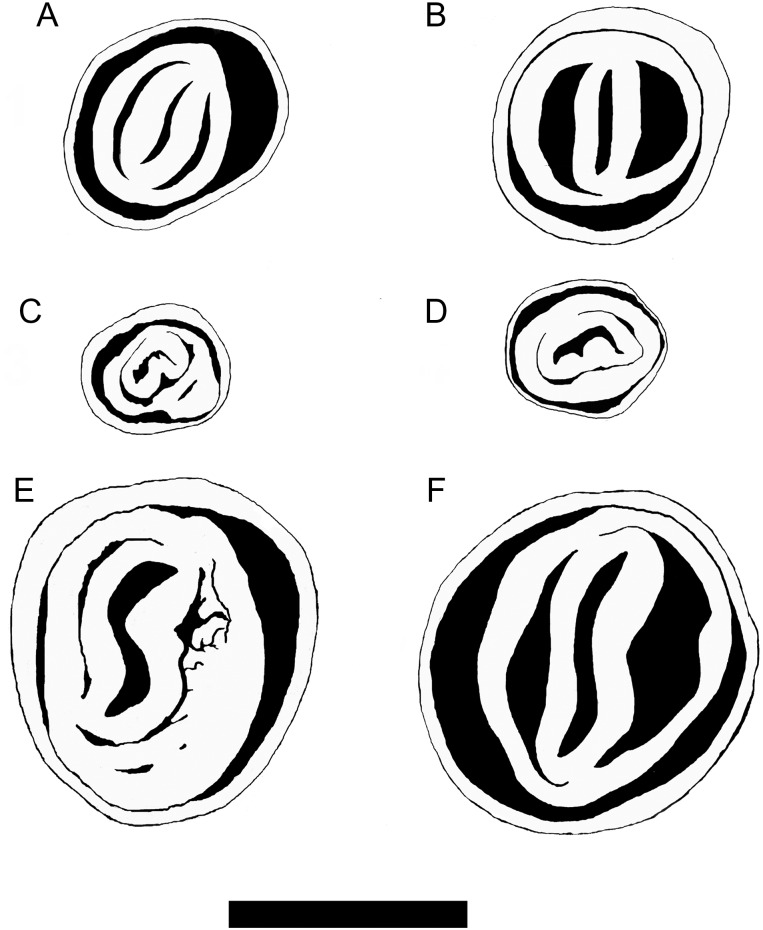
Ground patterns of penis cross section in the Trochulus hispidus complex, T. striolatus subspp. and T. oreinos subspp. A. T. hispidus complex with small folds. B. T. hispidus complex with broad folds. C. T. oreinos with additional fold and bulge (only found in T. o. oreinos). D. T. oreinos with no additional fold (only found in T. o. scheerpeltzi). E. T. striolatus with folds with protuberances (mainly found in T. s. striolatus). F. T. striolatus with smooth folds (found in T. s. danubialis and T. s. juvavensis). Scale bar = 1 mm.